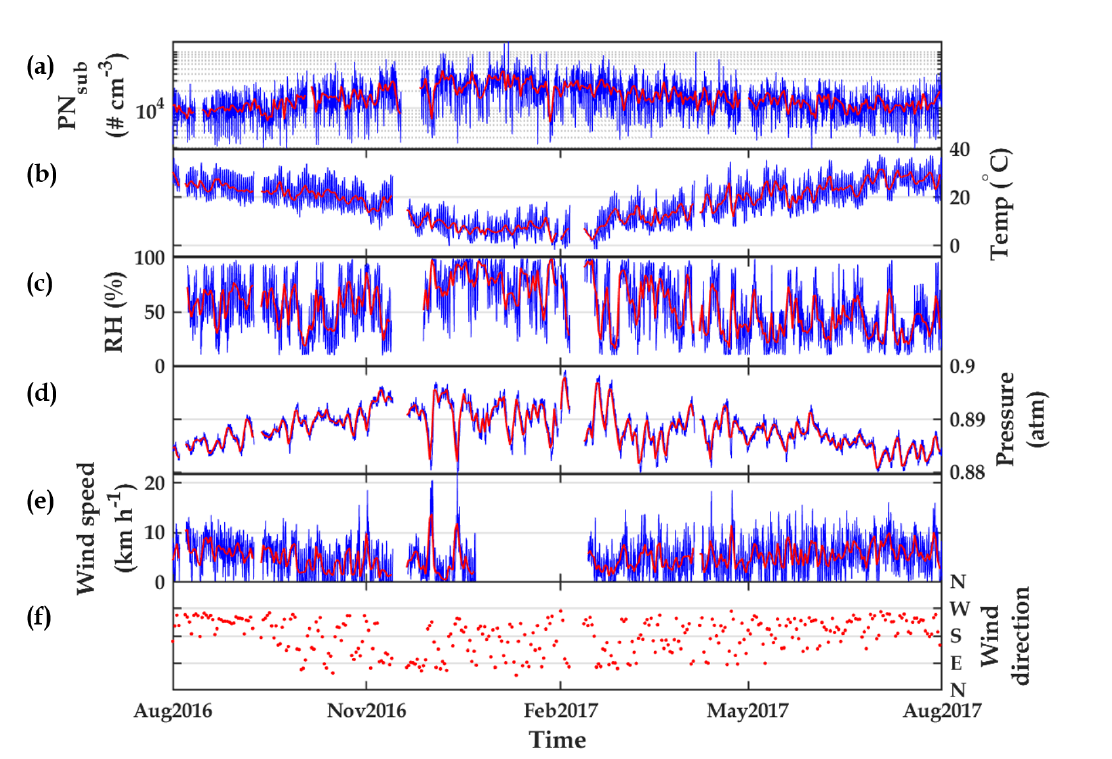
Figure 1. PNsub, shown in subfigure ( a ), and meteorological conditions, shown in subfigures ( b – f ), during the experiments. Red and blue colors are daily and hourly averaged.